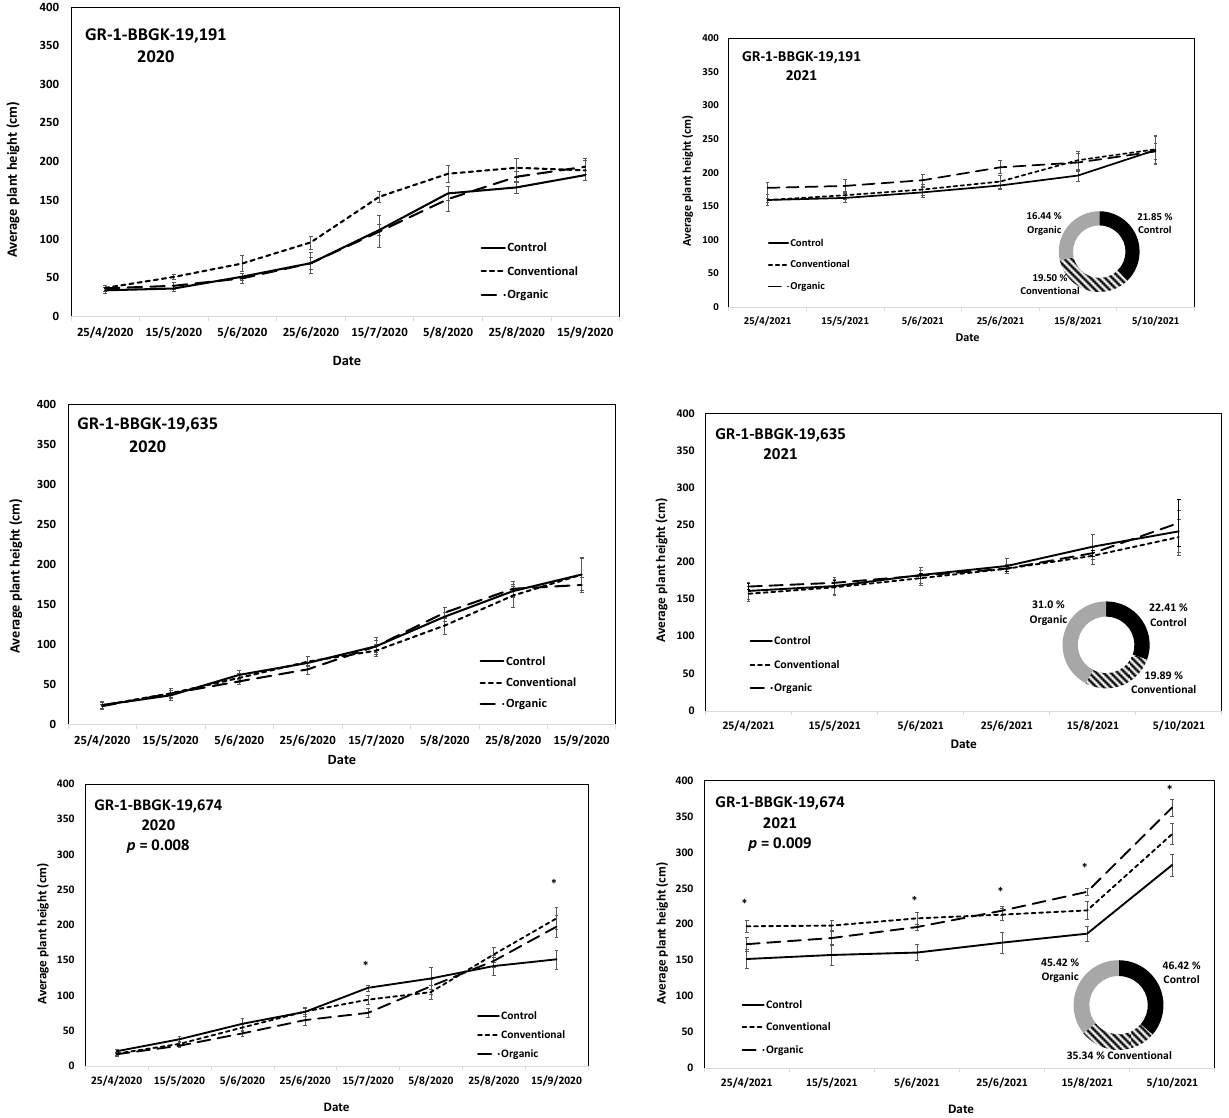
Figure 1. Plant growth patterns expressed as average plant height (cm) for Rosa canina genotypes GR-1-BBGK-19,193, GR-1-BBGK-19,191, GR-1-BBGK-19,635, and GR-1-BBGK-19,674 during the first two years of the pilot field trial (2020 and 2021) for the three fertilization treatments applied (control, conventional, and organic). Standard errors of the means are shown on the graphs ( p < 0.05). The treatment effects over time (within-subjects effects) were assessed via a Repeated Measures ANOVA separately for each genotype and year and were found significant in all cases ( p < 0.05). In cases where significant fertilization treatment effects (not over time, between-subjects effects) were observed, the respective p values are given, coupled with asterisks that denote dates when significant differences between treatments were observed after discreet analyses for each measurement date via Tukey’s HSD mean comparison ( p < 0.05). In the 2021 graphs per genotype, the rate of juvenile growth expressed as percentage (%) of tree height increase between 6 and 18 months after planting for each fertilization treatment measured independently, is comparatively given in respective circular